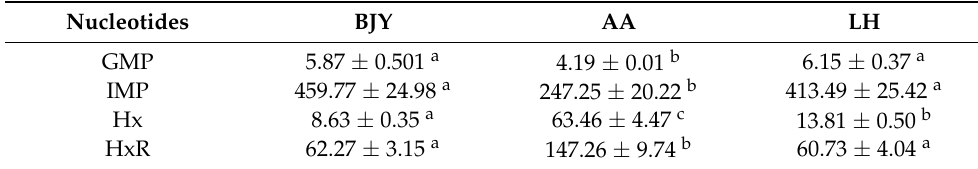
Table 2. Nucleotide contents of different types of chicken breast (mg/100 g).